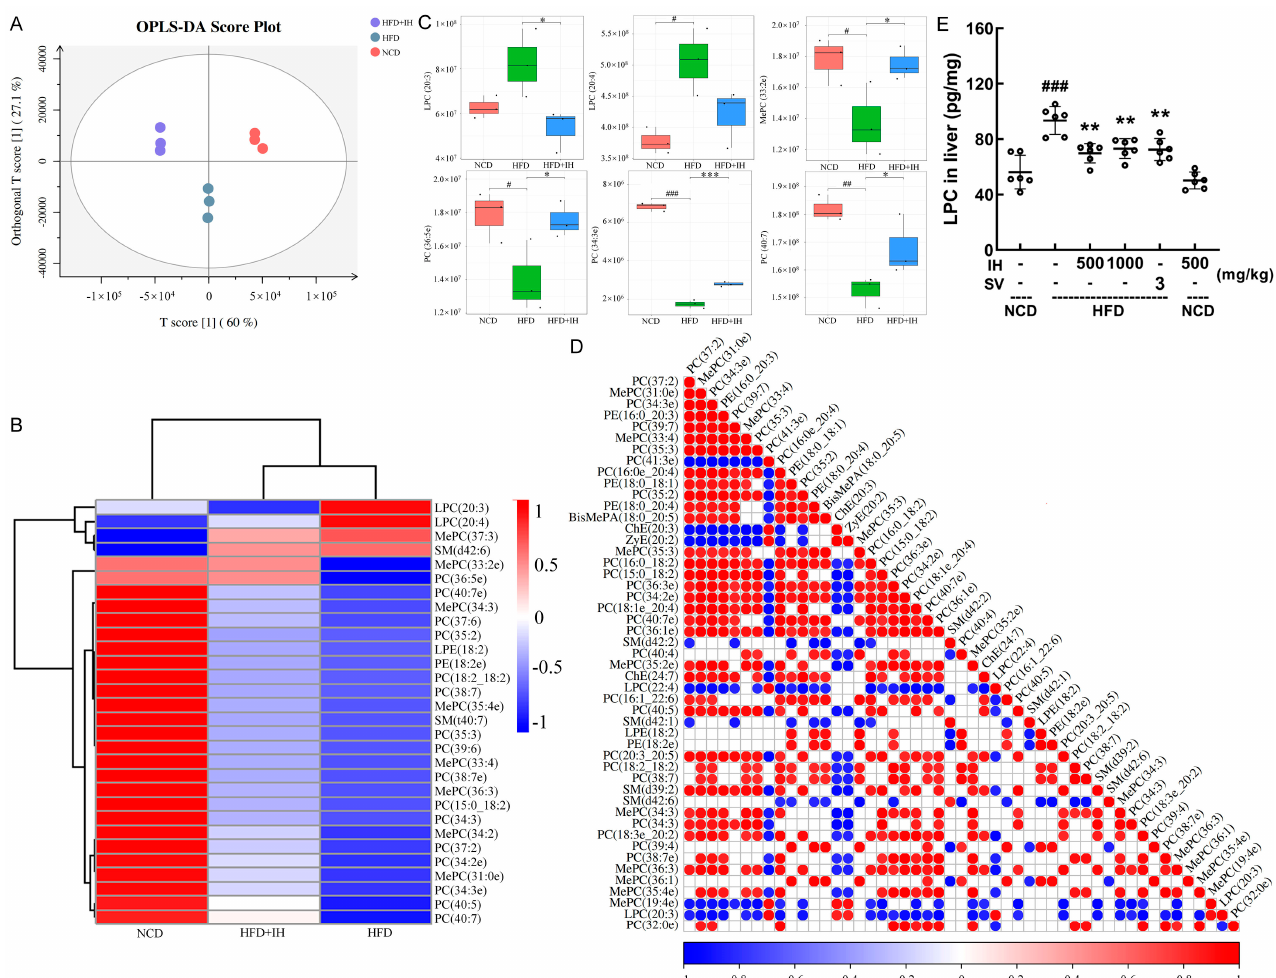
Figure 4. IH regulated lipid metabolites in HFD-fed mice. ( A ) OPLS-DA score plot. ( B ) Heatmap of significantly altered metabolites. ( C ) Boxplots of representative differential lipids affected by IH ( n = 3). ( D ) The associated heatmap of associated lipids. ( E ) IH decreased the level of LPC in the livers of HFD-fed mice. # p < 0.05, ## p < 0.01, and ### p < 0.001 versus vehicle-treated NCD-fed